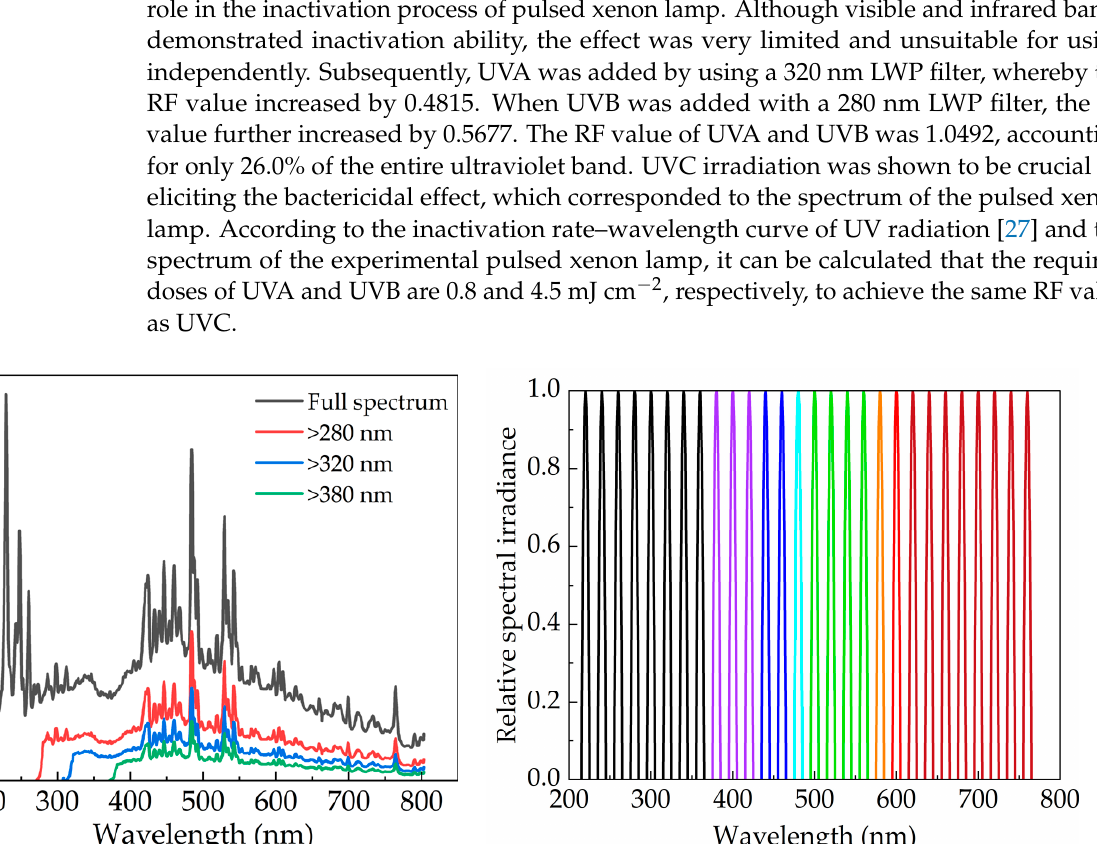
Figure 9. Sub-band RF values of pulsed xenon lamp. Table 3. RF values of various mono-color light wavelengths. Wavelength (nm)